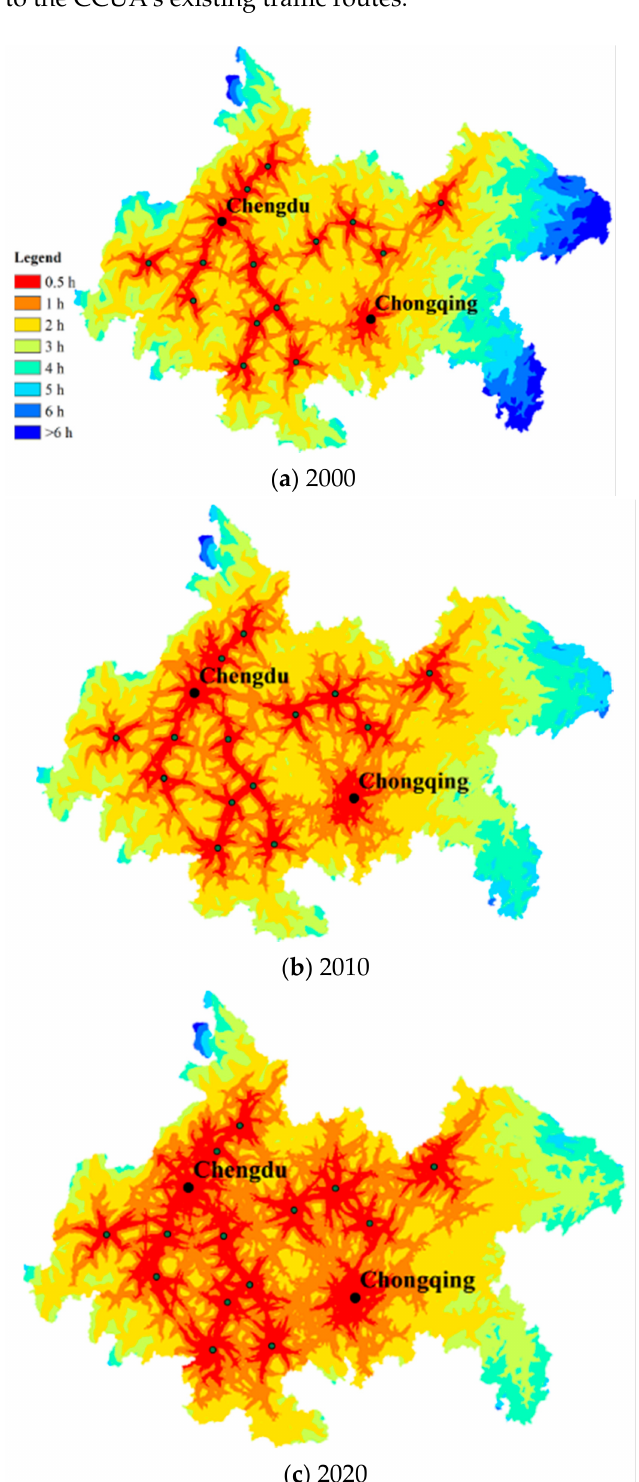
Figure 4. CCUA’s traffic isochronous